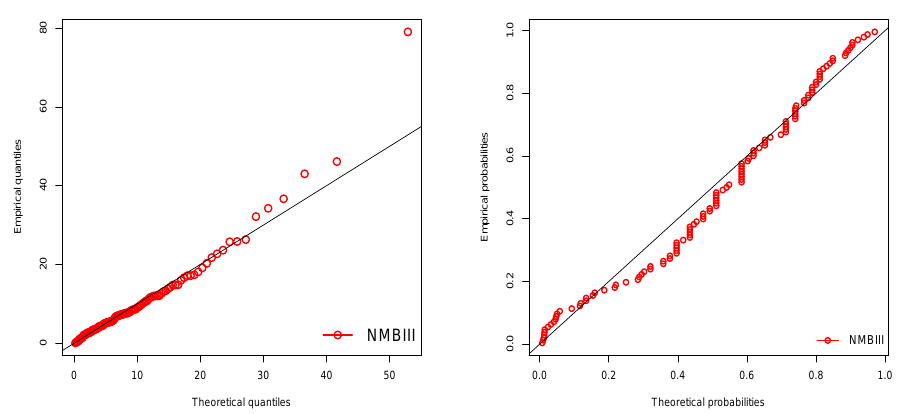
Figure 3. Estimated density ( top left ), cdf ( top right ), QQ-plot ( bottom left ), and PP-plot ( bottom right ) for data set 1.